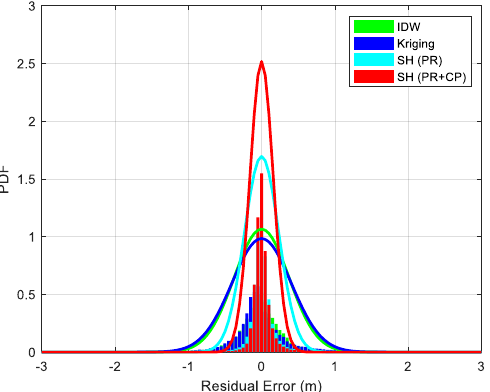
Figure 9. Probability distribution function for the residual error of each algorithm (simulation). IDW: inverse distance weight, SH (PR): spherical harmonics using only the pseudorange, SH (PR + CP): spherical harmonics using both the pseudorange and double difference carrier phase.